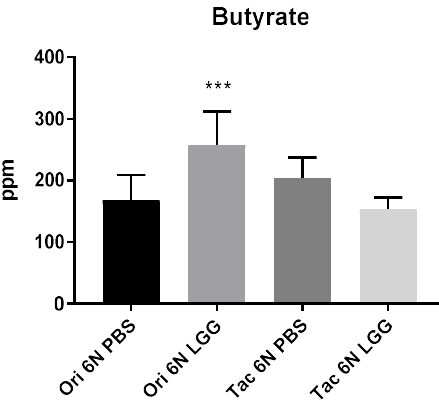
Figure 7. Butyrate production in the fecal samples after probiotic (LGG) treatment (compare also with Figures 5 and 6). The amount of butyrate in the fecal sample was measured by gas chromatography. The detection units for the butyrate are given as parts per million (ppm). Ori 6N PBS and Tac 6N PBS groups received 200 µL of PBS, while 200 µL of LGG were administered to Ori 6N LGG and Tac 6N LGG groups twice a day for four weeks. For each group, 4–5 fecal samples were analyzed. The data are represented as the means ± SD and were analyzed by Fisher’s LSD test compared to the Ori 6N PBS group. Significance is indicated when * p < 0.05, ** p < 0.01, and *** p < 0.001.